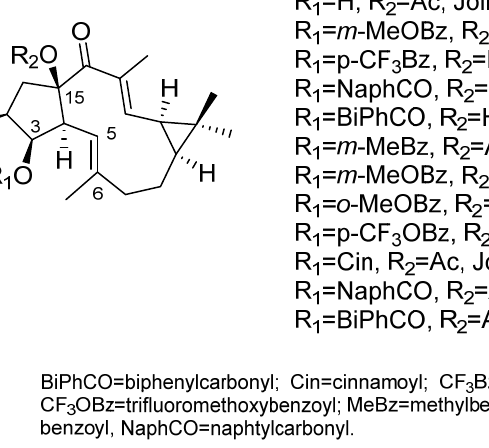
Figure 5. Chemical structures of jolkinol D derivatives (compounds 31 – 42 ) with MDR-modulating activity.